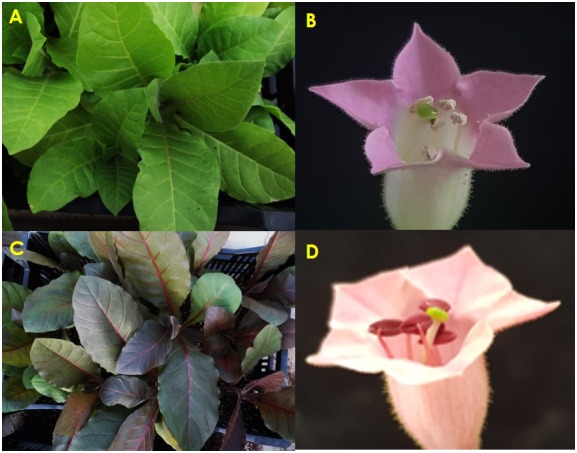
Comparing the difference in phenotypes between WT and T0-Ros1 plants; leaves of WT (A) and T0-Ros1 (C), and flowers of WT (B) and T0-Ros1 (D) (under greenhouse conditions).